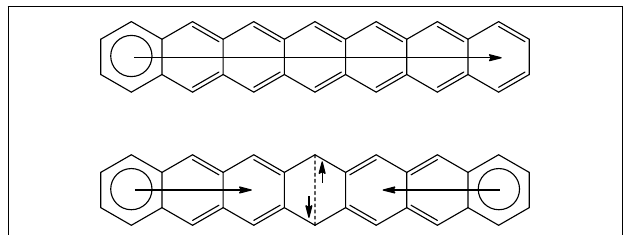
Scheme 11 | Clar structures for the closed-shell and open-shell singlet states of